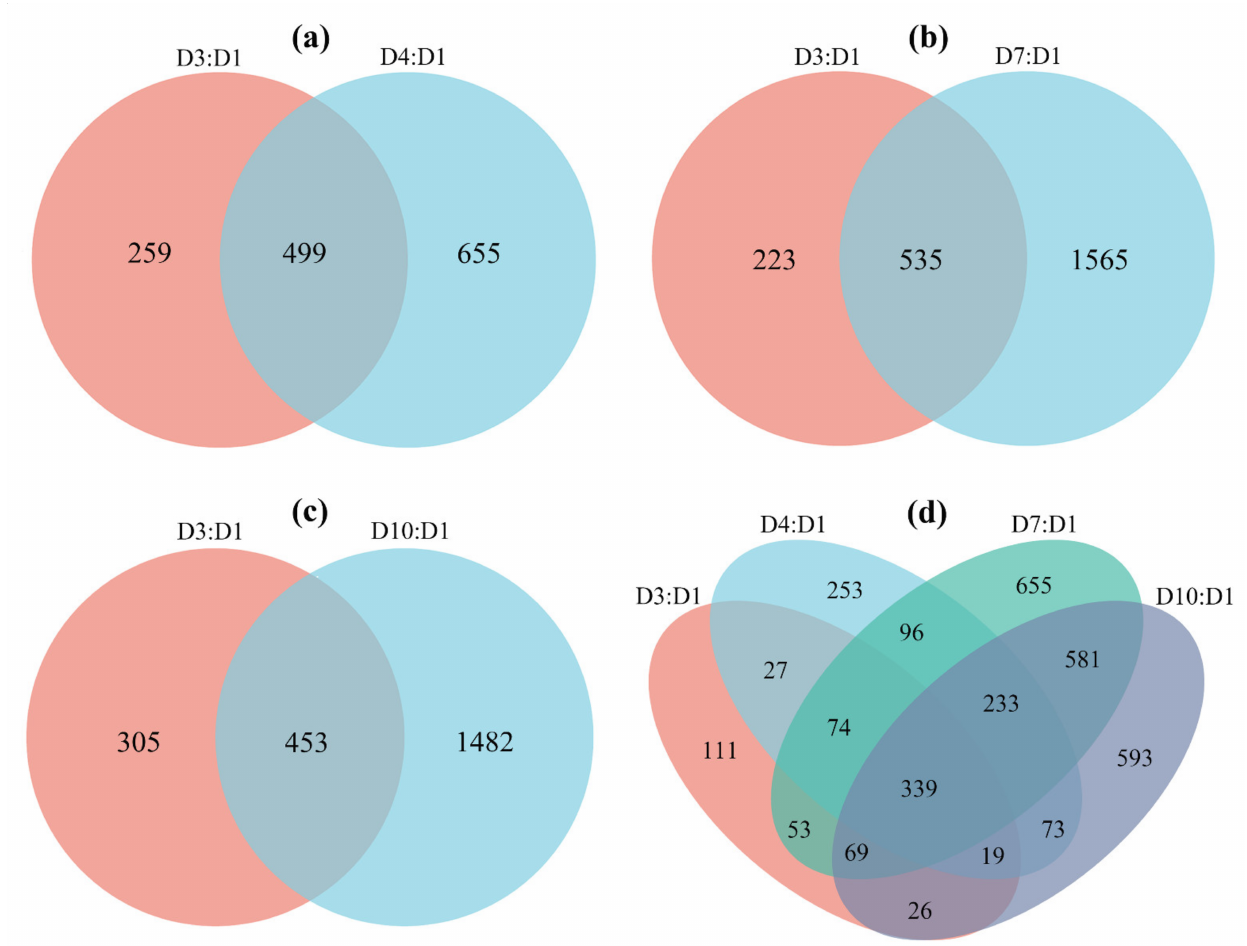
Figure 3. Venn diagrams of DEGs from the flight muscle of S. frugiperda females. ( a – c ) are common DEGs within D3:D1 and D4:D1 groups, D3:D1 and D7:D1 groups, and D3:D1 and D10:D1 groups, respectively; and ( d ) is common DEGs among the four groups (D3:D1, D4:D1, D7:D1 and D10:D1). The overlapping circles represented common DEGs among all